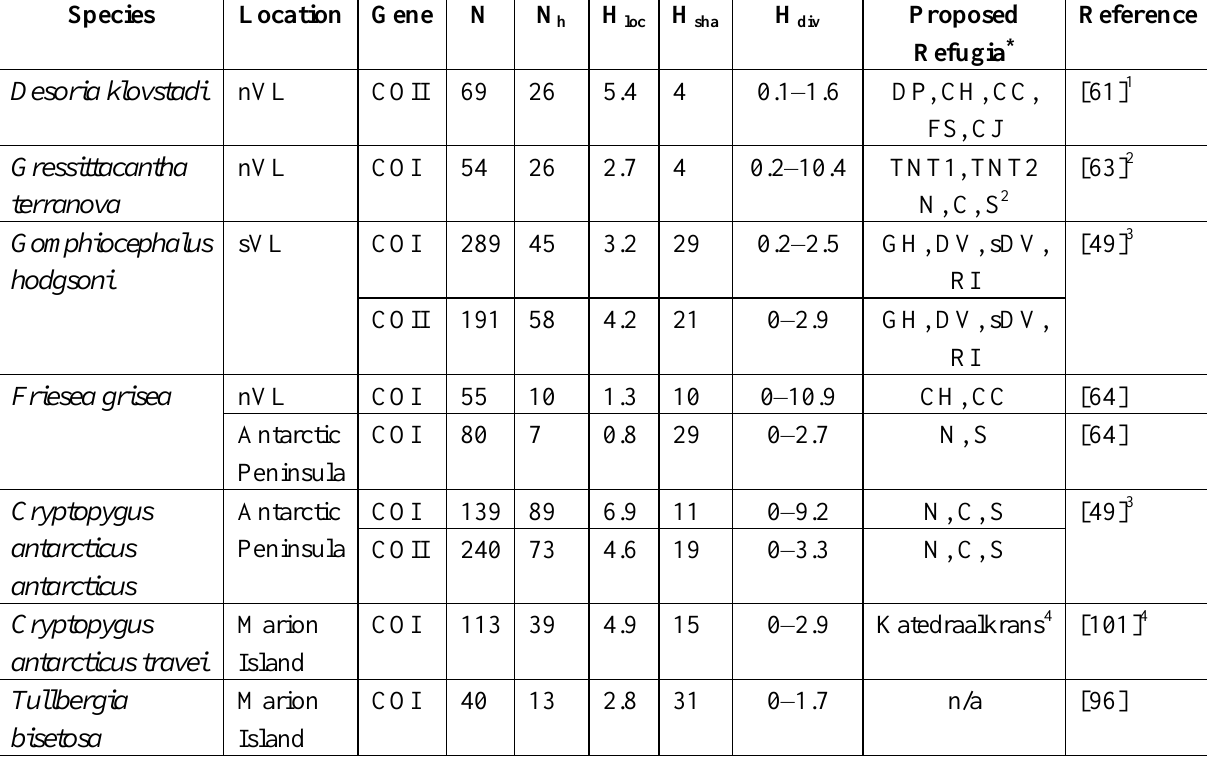
Table 1. Summary of phylogeographic analyses performed to date on springtails in Antarctica, including information on species, location, gene (all mitochondrial DNA), number of individuals sampled, (N); number of haplotypes; N ; mean number of h haplotypes per location/population, (H ); percentage of haplotypes shared among loc locations/populations, (H ); percentage divergence (uncorrected p-distance) range among sha haplotypes (H ); phylogeographically-proposed refugial location(s); and reference to the div literature. nVL and sVL: northern and southern Victoria Land, respectively. See Figure 1 for proposed refugial location